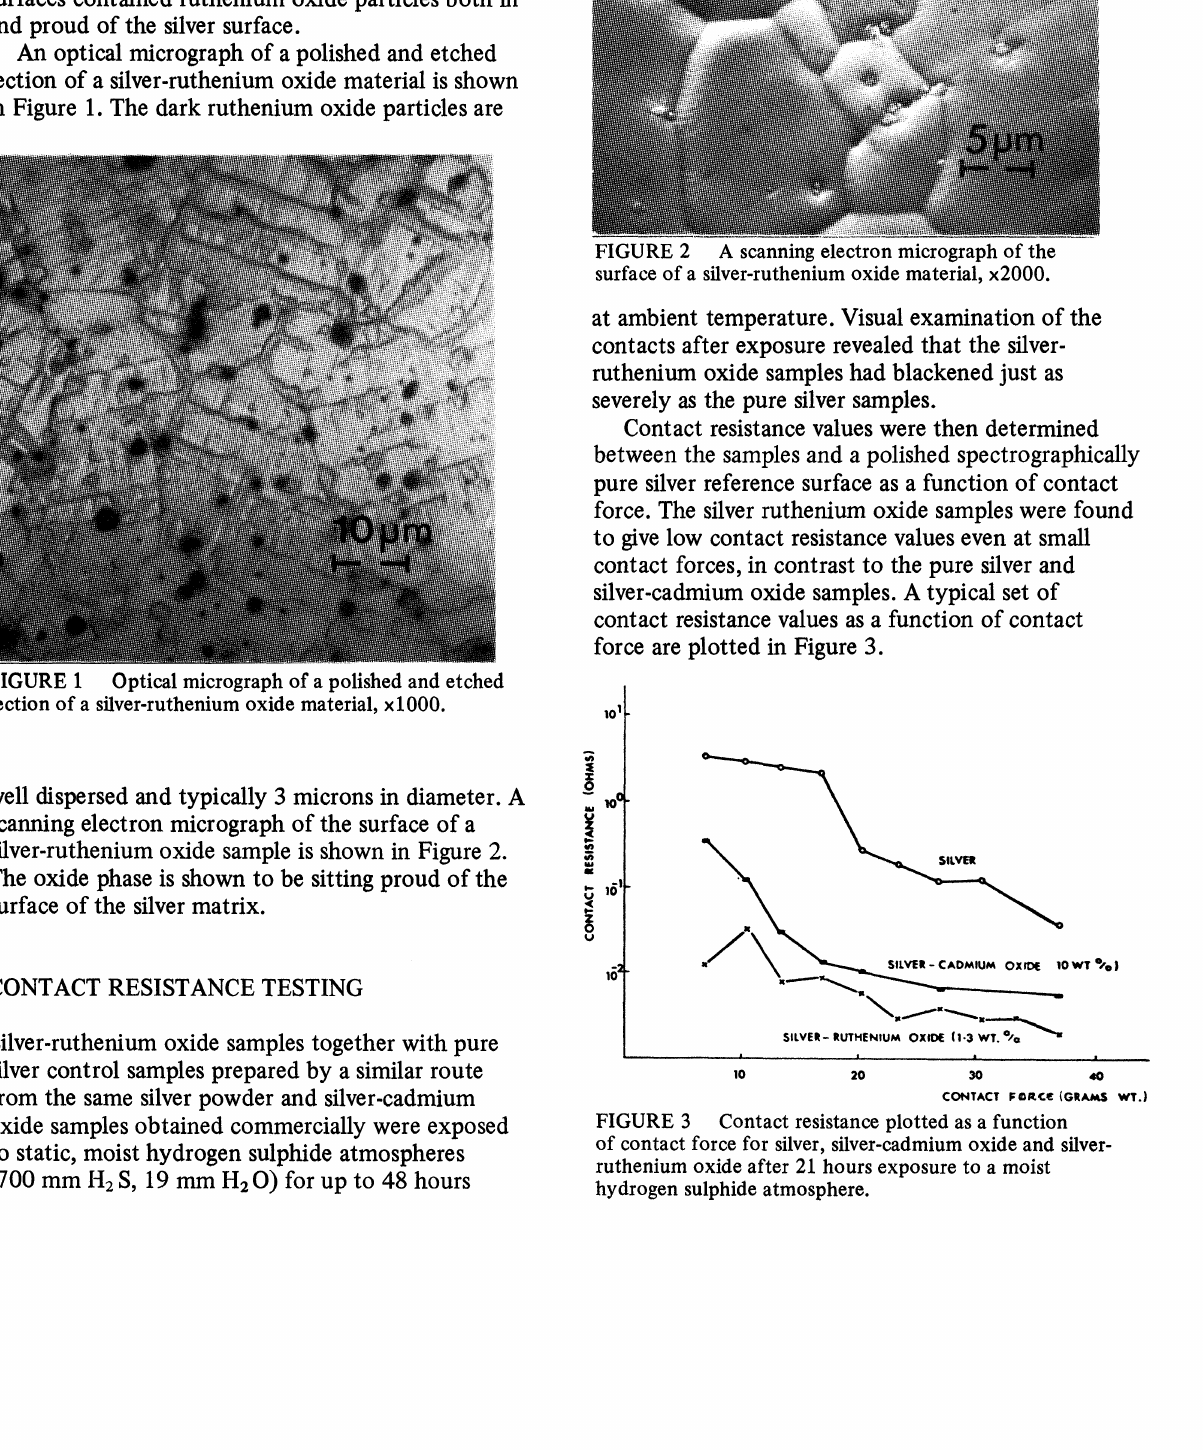
well dispersed and typically 3 microns in diameter. A